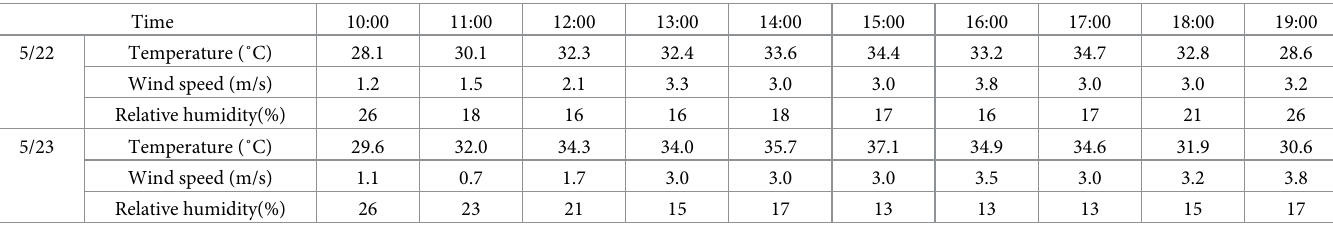
Table 2. Hourly meteorological data from 10:00–19:00 on May 22 nd and 23 rd , 2019.